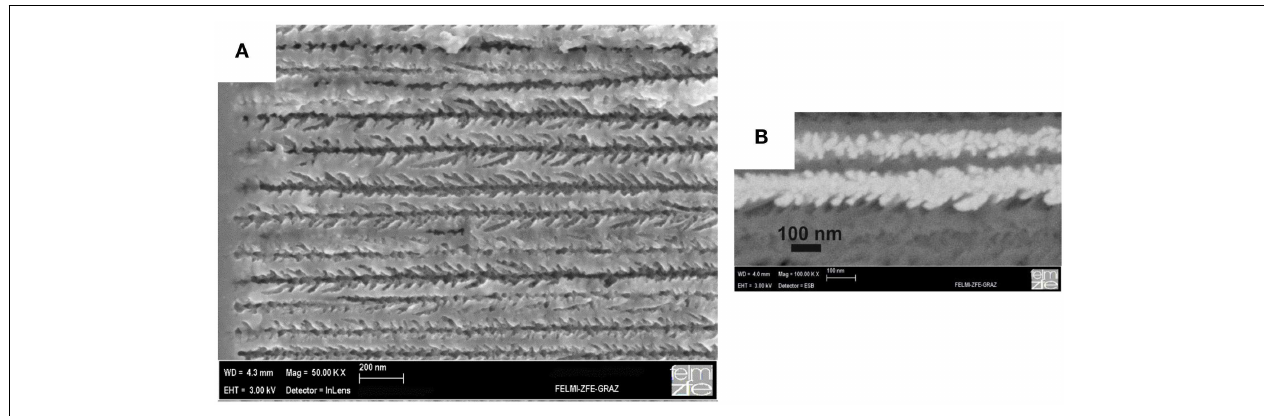
FIGURE 7 | (A) Cross-sectional SEM image of a porous silicon template showing the dendritic pore-growth. (B) BSE-image of Ni-wires deposited within the pores of porous silicon showing their branched structure coinciding with the dendritic pore-growth.